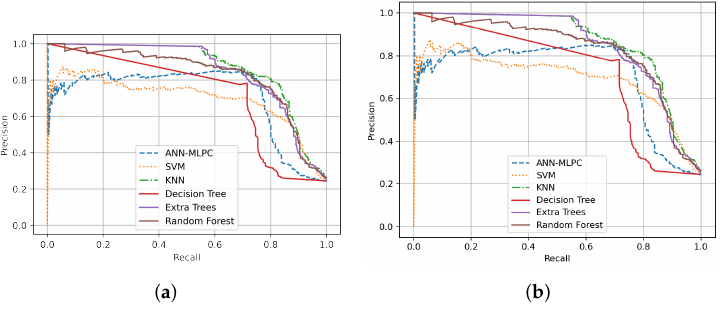
Figure 4. PR curves. ( a ) PR curve on PC, and ( b ) PR curve on Raspberry Pi